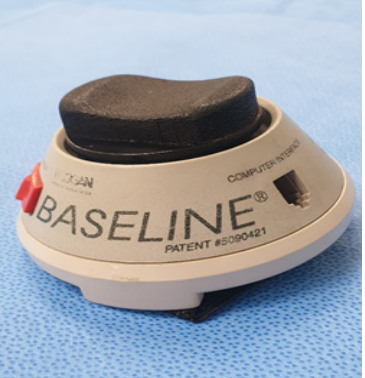
Figure 4. MicroFET II TM (Hoggan Health Industries, Draper, UT, USA).